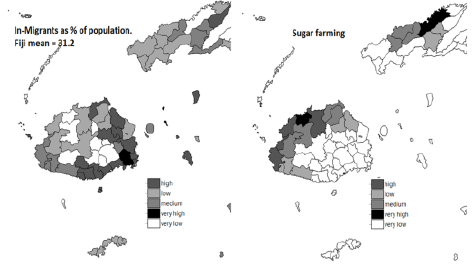
Figures 6a. Fiji islands map showing degrees (in percentage) of Fijian population per tikina . Range: under 45 to 100. Figure 6b. The country‘s map showing degrees of tertiary education (in percentage) per tikina. Range: 0 to 21.